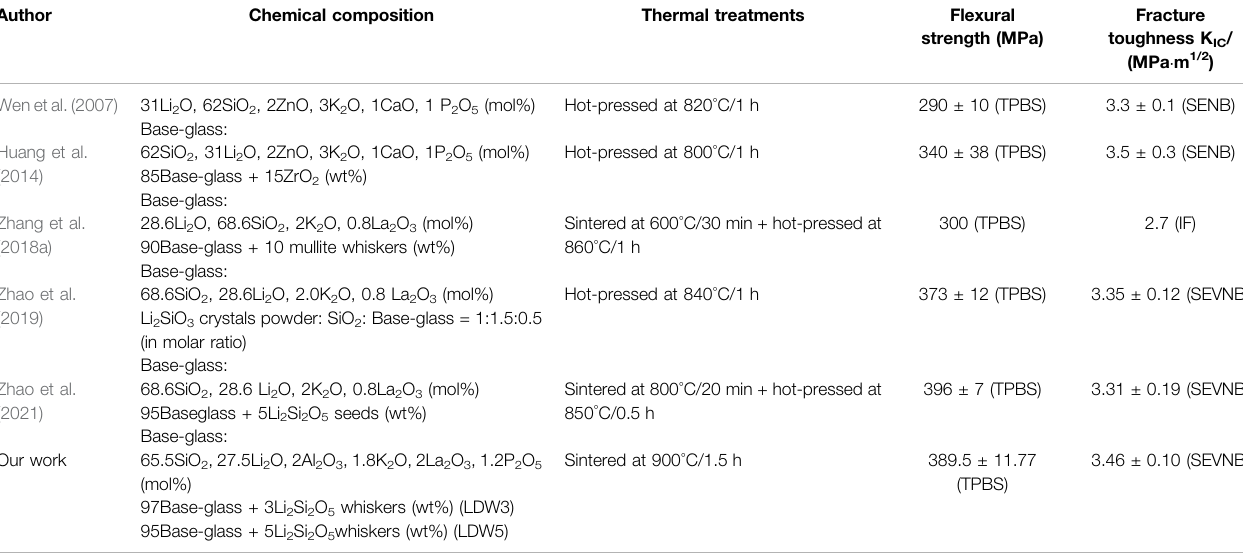
TABLE 2 | Comparison of the mechanical properties of Li 2 Si 2 O 5 glass-ceramics between reported studies and the current study. Chemical composition Thermal